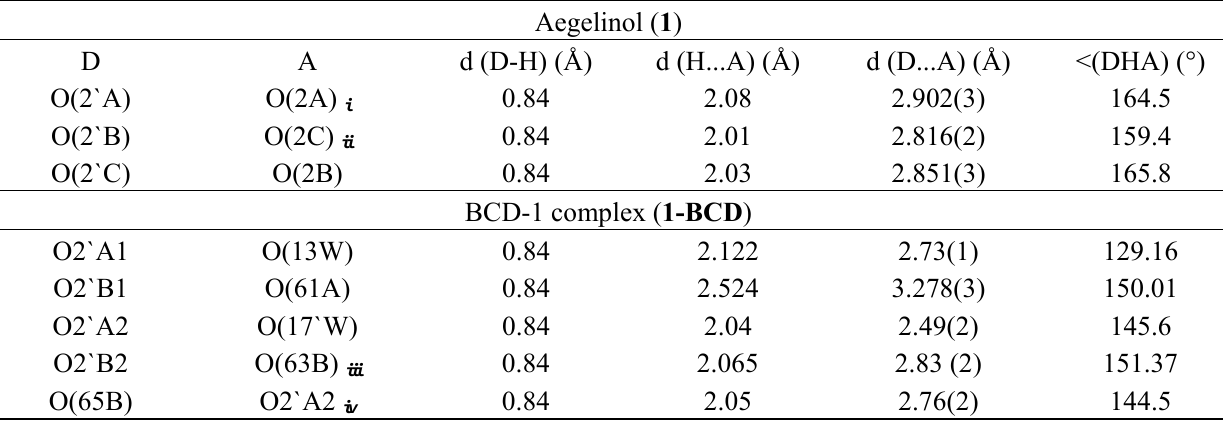
Table 3. Selected hydrogen